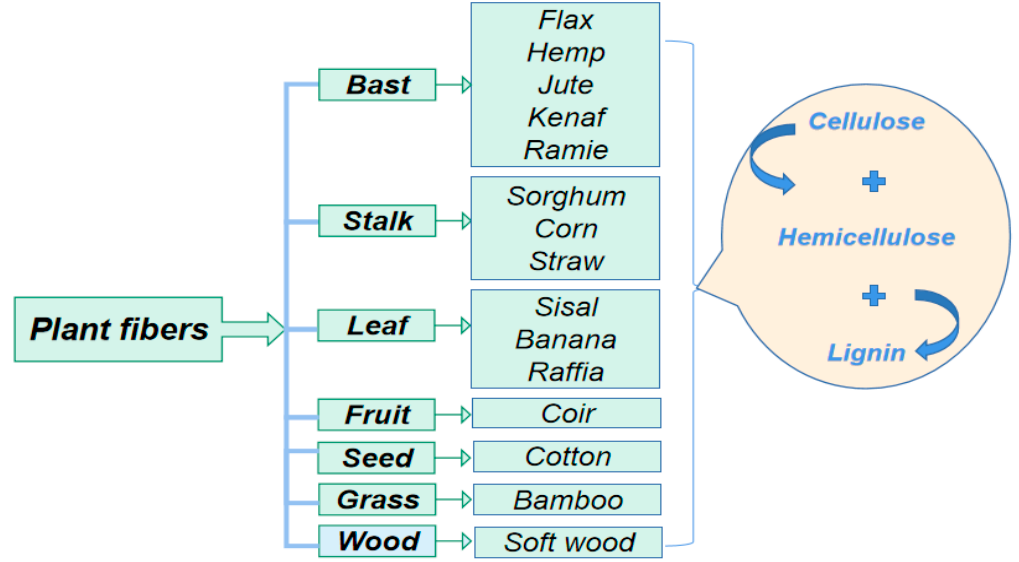
Figure 1. Classification of commonly used PF reinforcements.